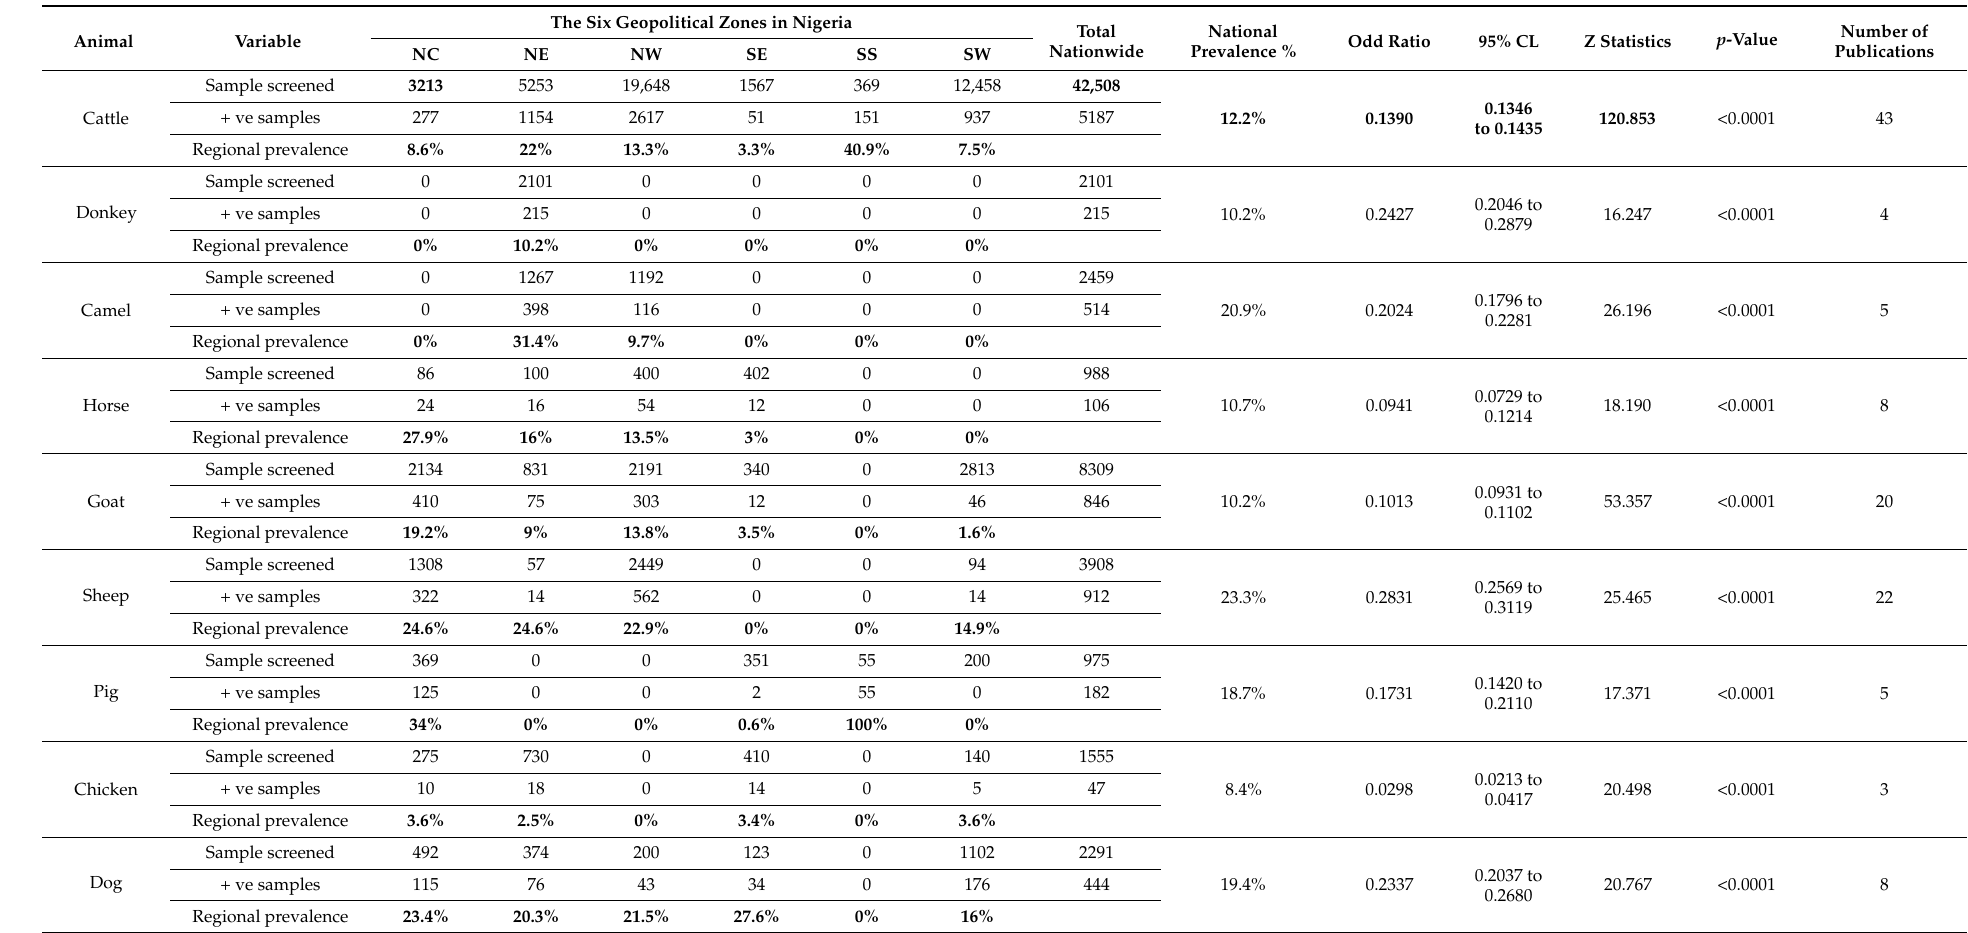
Table 2. National prevalence of brucellosis for different domestic animals in Nigeria